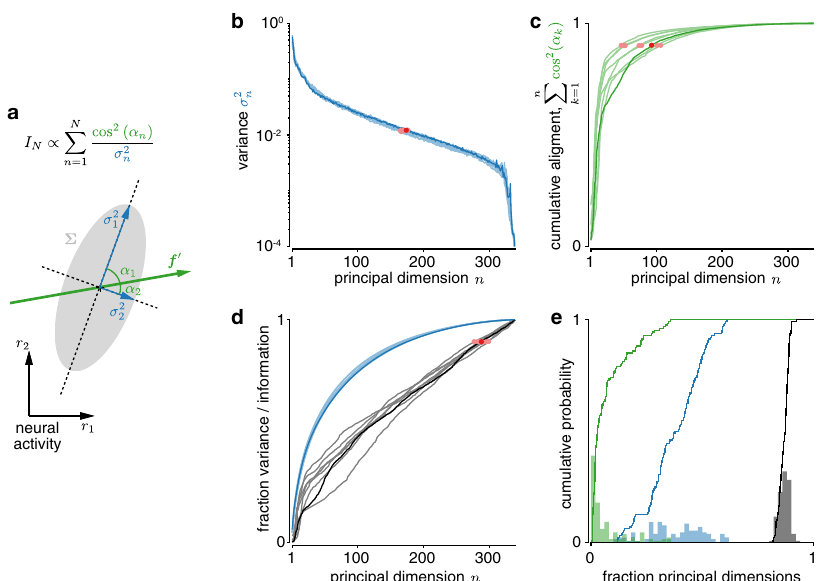
Fig. 8 Information is not well-aligned with principal noise dimensions. a The total information in a recorded population, I N , can be decomposed into how well the change in population tuning, f ′ , is aligned to the different principal dimensions of the noise covariance (given by cos 2 ( α n )), as well as the noise variances, σ 2 n , in these dimensions. Low-variance dimensions that are strongly aligned to f ′ contribute more information. b The variance along principal dimensions drops rapidly with dimension (red dots: >90% of total variance). c The cumulative alignment of f ′ to the principal dimensions of the noise covariance rises rapidly with principal dimension (red dots: >90% of total alignment), indicating that f ′ is most strongly aligned to the fi rst few principal dimensions. d The fraction of total information (black; red dots: >90% information) rises more slowly with additional principal dimensions than the fraction of total noise variance (blue). The principal dimensions in panels b – d are ordered in decreasing order of variance, and show data for the same session as in Fig. 3c (dark = same discrimination as in Fig. 3c; light = other δθ = 45 ° discriminations for that session). e The histograms (bar plots) and cumulative probabilities (lines) of the fractions of the total number of principal dimensions at which the cumulative f ′ alignment (green), cumulative variance (blue), and cumulative information (black) exceed 90% of their respective totals. These fractions are shown for all δθ = 45 discriminations, sessions, and mice. All estimates are cross-validated, and averaged across ten train/test splits (see “ Methods ”